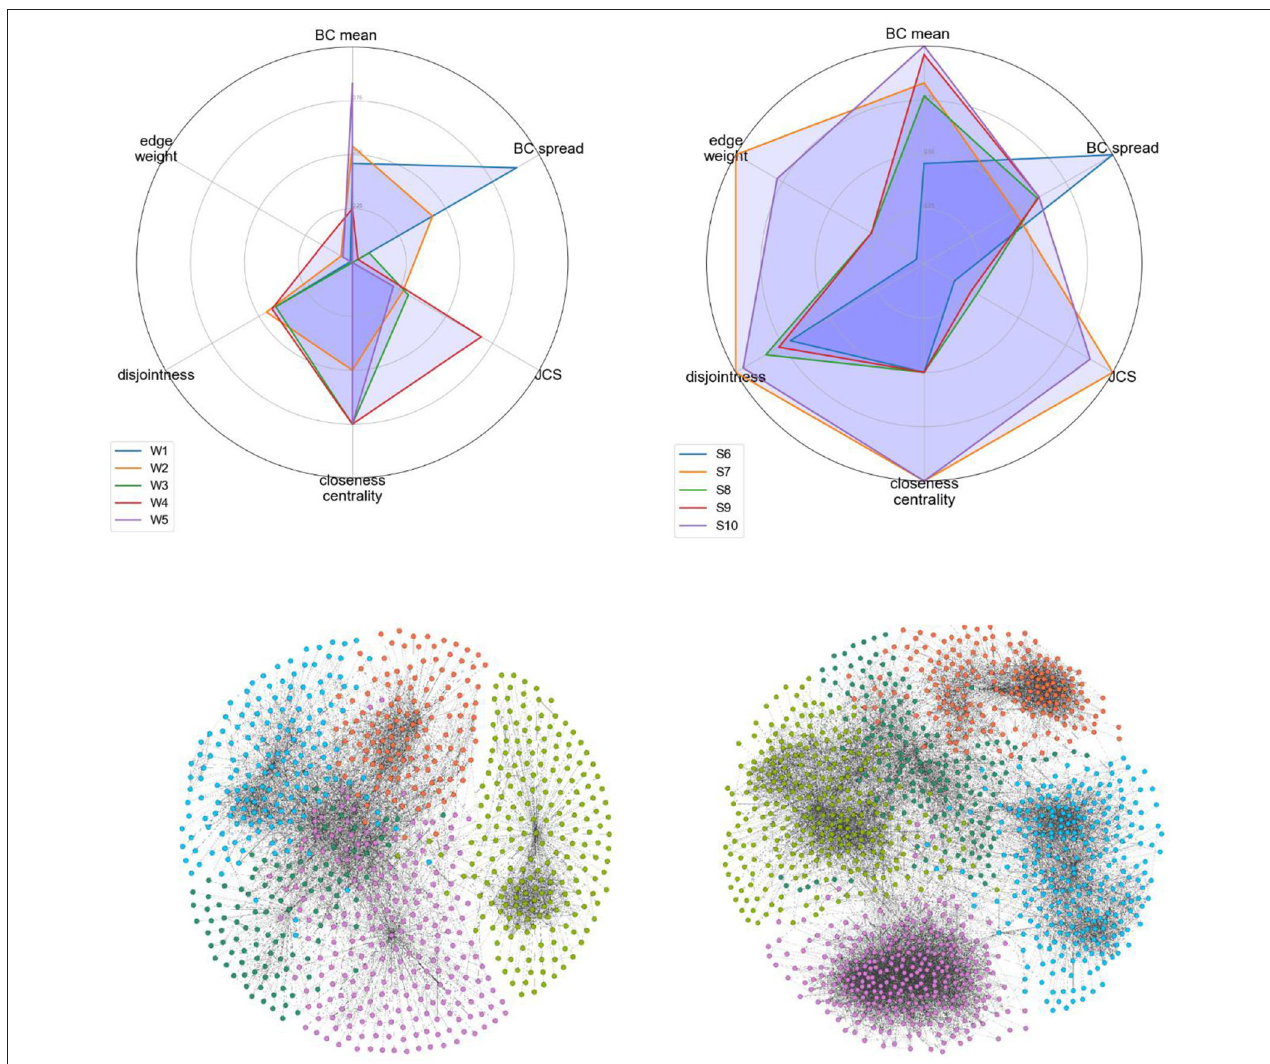
FIGURE 11 | Visualizing all the candidate networks.